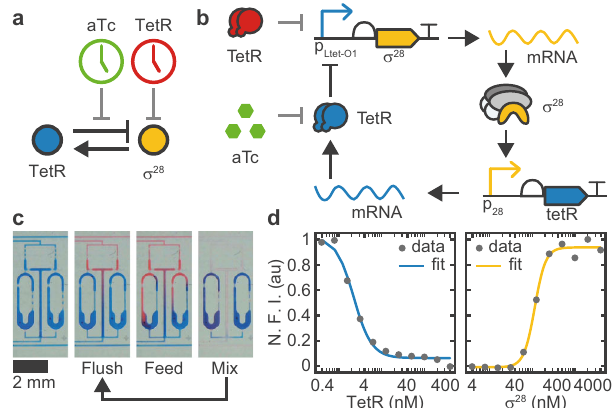
Fig. 1 Genetic oscillator circuit and experimental setup. ( a ) Simple and ( b ) detailed circuit diagram of the synthetic genetic oscillator consisting of a negative feedback loop where σ 28 acts as activator and TetR acts as repressor. Our four-variable ODE model (Eqs. (1) – (4)) considers the concentrations of the two proteins and their respective mRNAs. Protein expression is monitored via co-expression of fl uorescent reporters mVenus and mTurquoise2, respectively. We can perturb the system either by inactivating existing TetR by induction with aTc, or by adding puri fi ed TetR. c A micro fl uidic ring reactor 16 was used to maintain the reaction out-of- equilibrium by periodically exchanging a fraction of the reactor volume with fresh reagents. By switching between different input reagents, the reactions can be exposed to an arbitrary series of inputs. d Transfer curves of the two promoters determined by titrating the regulator protein in bulk. Fitted Hill parameters with 68% con fi dence intervals are K h = 2.2 ± 0.2 nM, n h = 2.1 ± 0.3, K a = 115 ± 6 nM, n a = 3.4 ± 0.6. N.F.I. Normalized Fluorescence